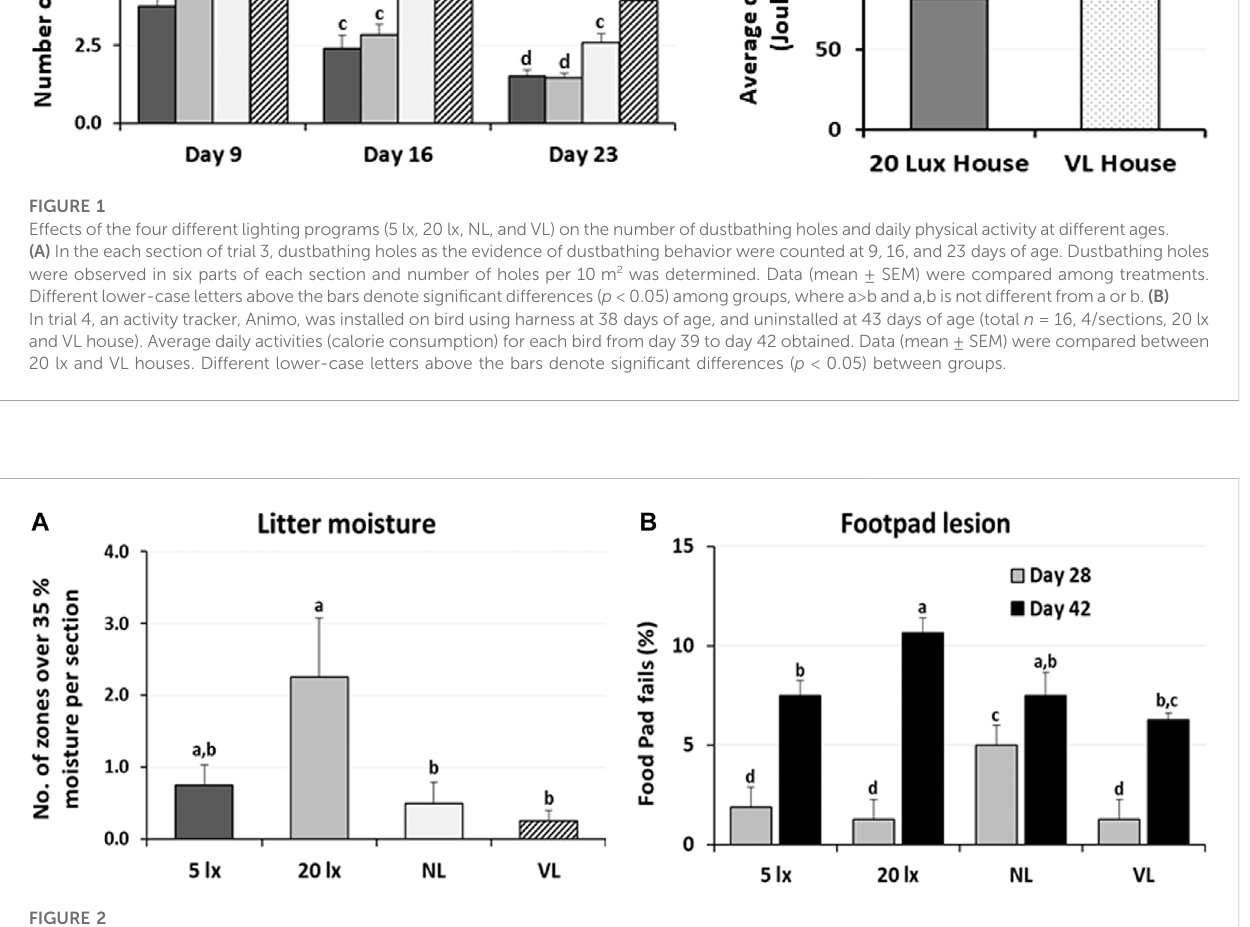
FIGURE 2 Effectsofthefourdifferentlightingprograms(5lx,20lx,NL,andVL)onthelittermoistureandfootpadhealth. (A) Intrial1,conditionoflittermoisture was accessed by thehand-clumping method. When litter begins to retain moisture and moisture contentis over 35%, it clumps together. Sevendifferent areas(zones)ofeachsectionweretestedifthelitterclumpsbyhand. Averageofnumberofzones persectionwithpositive hand-clumpingwasobtained ineachtreatmentoflightprogramsandcomparedamongtreatmentgroups. (B) Intrial3,footpadconditionwascheckedat28and42 daysofagein each section of the treatment houses ( n = 10/section, 4 sections/house). Percentage of footpad failed birds from the inspected birds was obtained and compared among treatment groups. Data (mean ± SEM) were compared among treatments. Different lower-case letters above the bars denote signi fi cant differences ( p < 0.05) among groups, where a > b > c. b,c is not different from b or